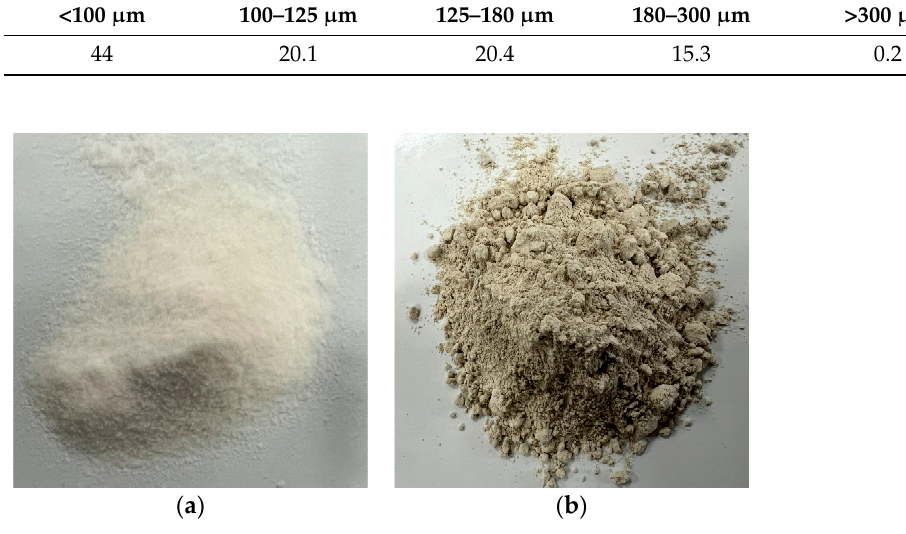
Figure 1. Raw materials. ( a ) SAP. ( b ) CEA.